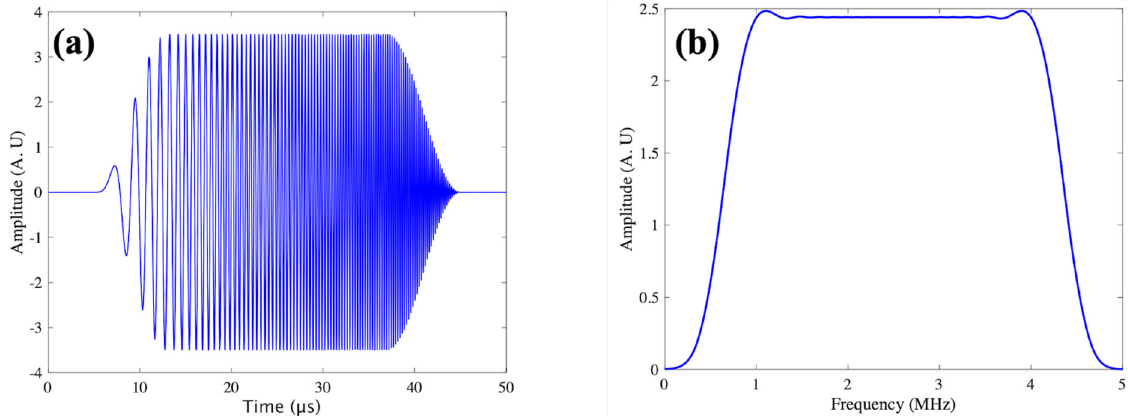
Figure 2. The excitation signal (Chirp) used in the experiment, the excitation signal ( a ), and its Fourier spectrum ( b ).